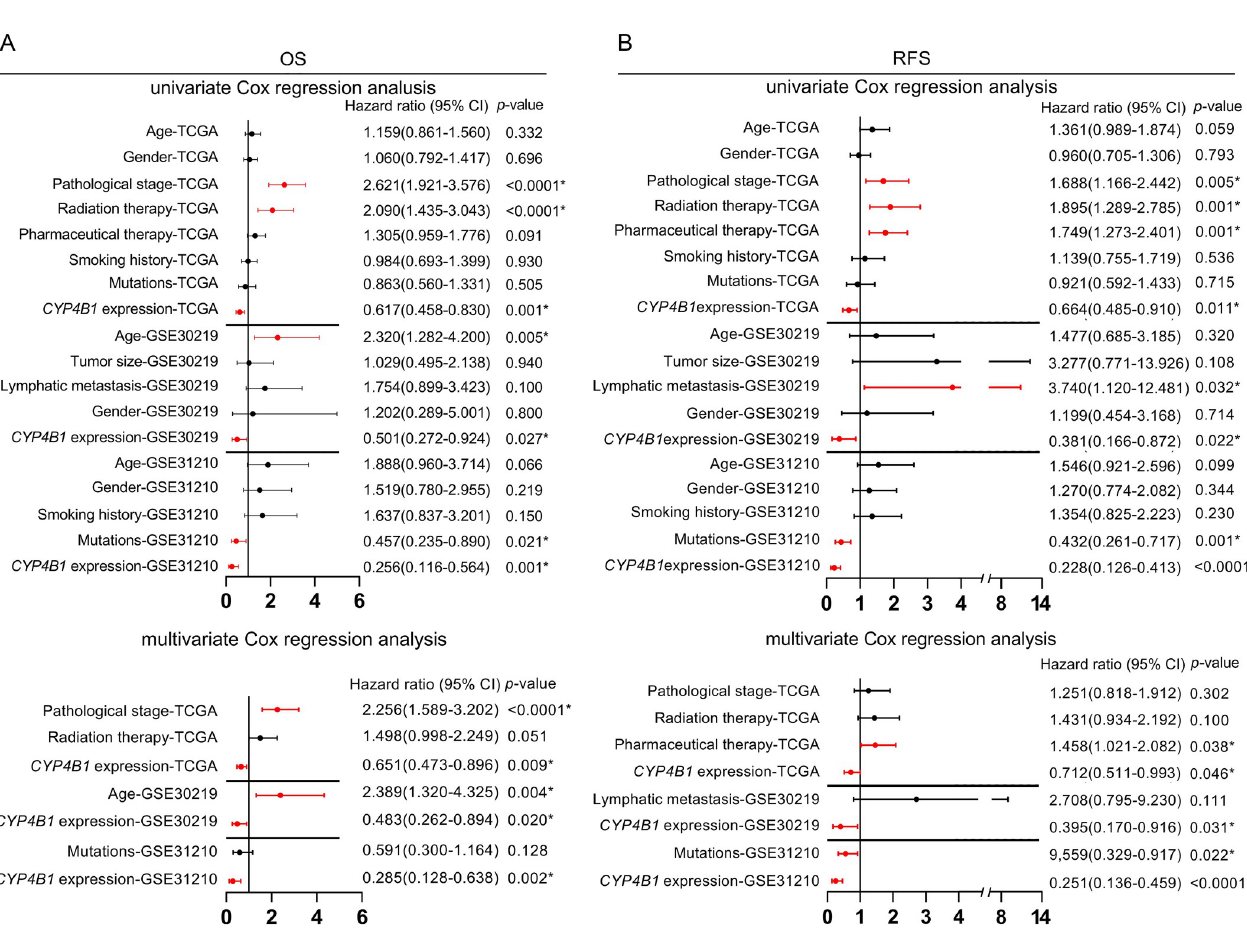
Fig 3. Forest plots of Cox regression analysis. (A) Forest plots showing univariate and multivariate analysis of OS in patients with LUAD. (B) Forest plots showing univariate and multivariate analysis of RFS in patients with LUAD. � p < 0.05. OS, overall survival; LUAD, lung adenocarcinoma; RFS, recurrence-free